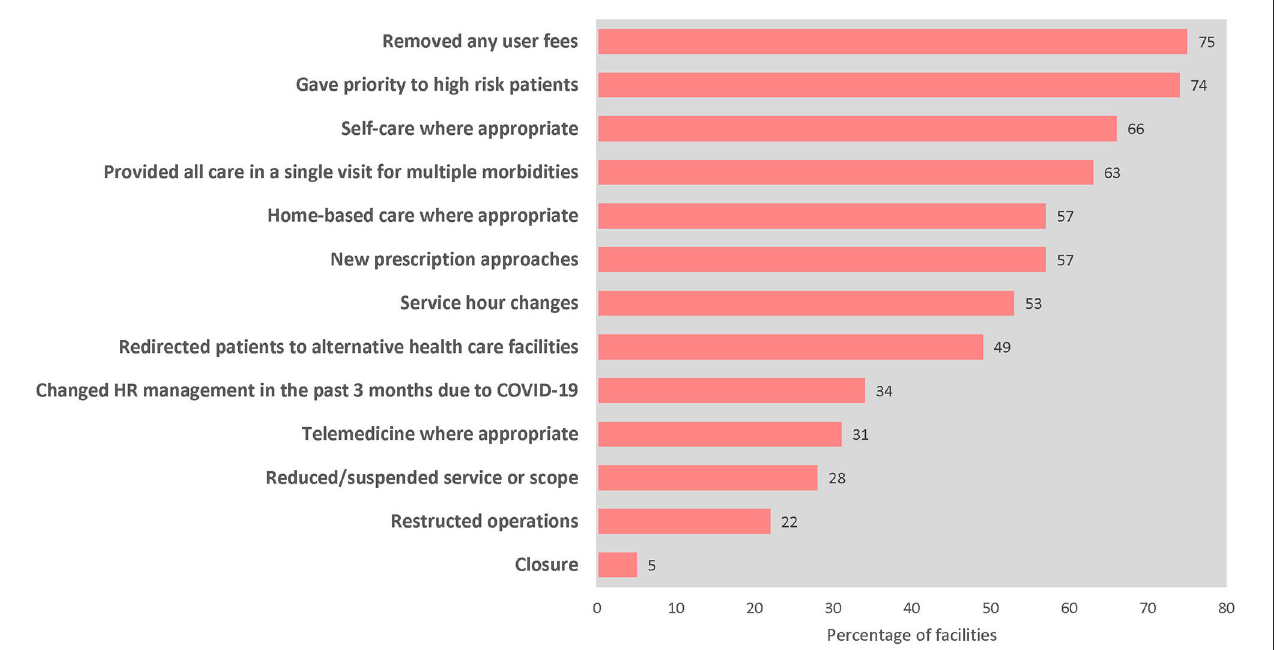
FIGURE2 Percentage of primary care facilities ( n = 2,377, 21 countries) that employed mitigation strategies to overcome service disruptions at the time of assessment (January 2021–March 2022).